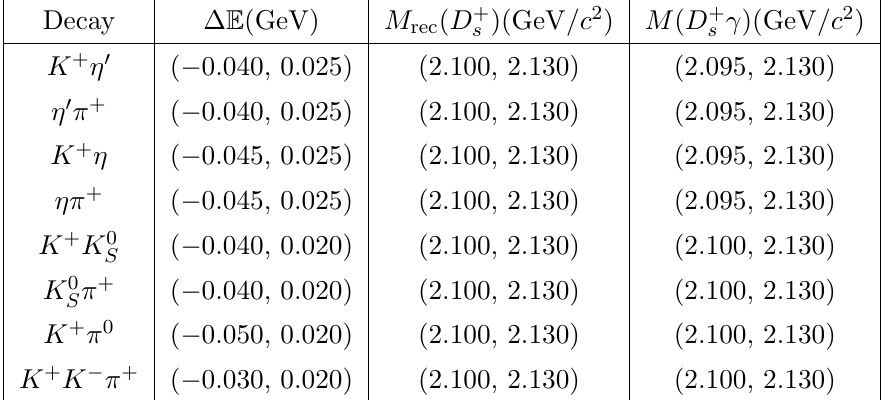
Table 2 . Summary of the requirements of (cid:1) E , M rec ( D + mode and the normalization mode.